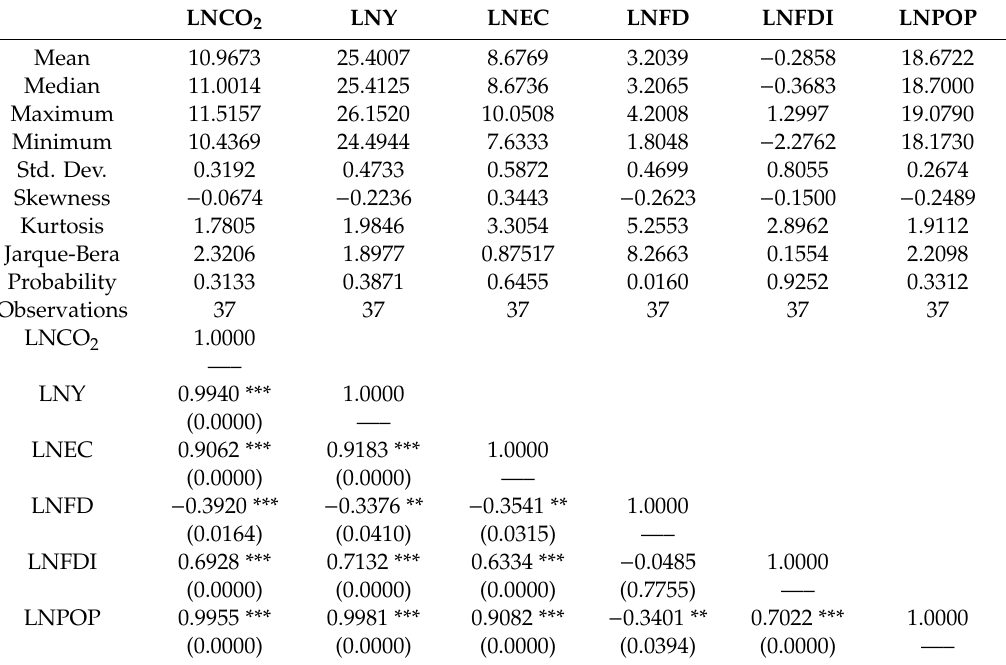
Table 2. Descriptive summary and correlation